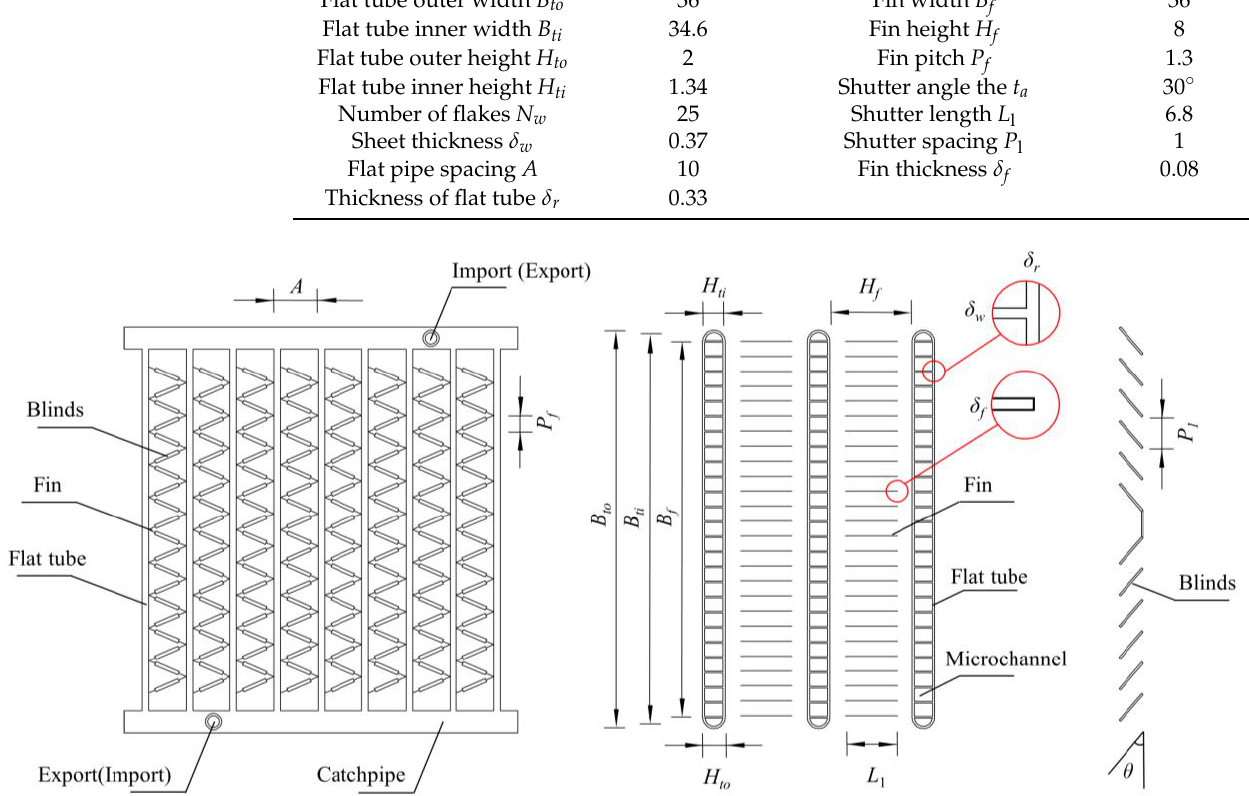
Figure 2. Structural dimensions of the microchannel heat exchanger.